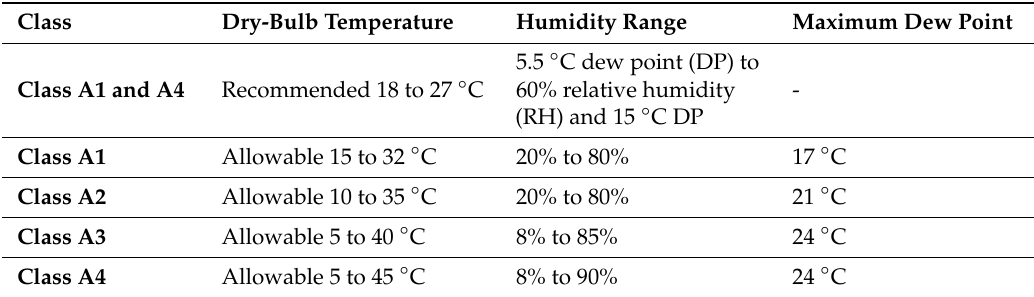
Table 1. American Society of Heating, Refrigerating, and Air-Conditioning Engineers (ASHRAE) thermal guidelines for data centers [29–31].